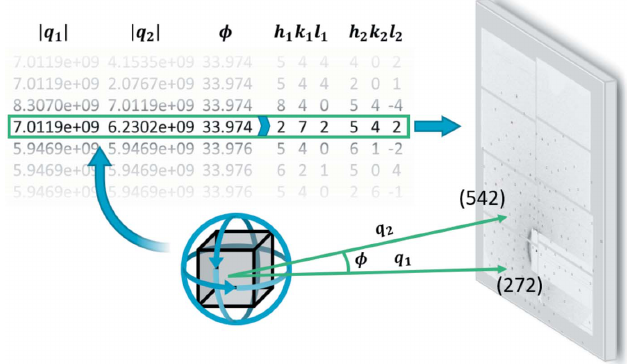
Figure 4 OM determination from a pair of reflections based on the SPIND algorithm. Scattering vector lengths and angles between them are calculated based on observed spot positions. On comparison with a reference table based on known unit-cell parameters, the reflections are indexed. The orientation matrix relative to the laboratory frame is then easily determined as the matrix that rotates the same reflections on top of each other.